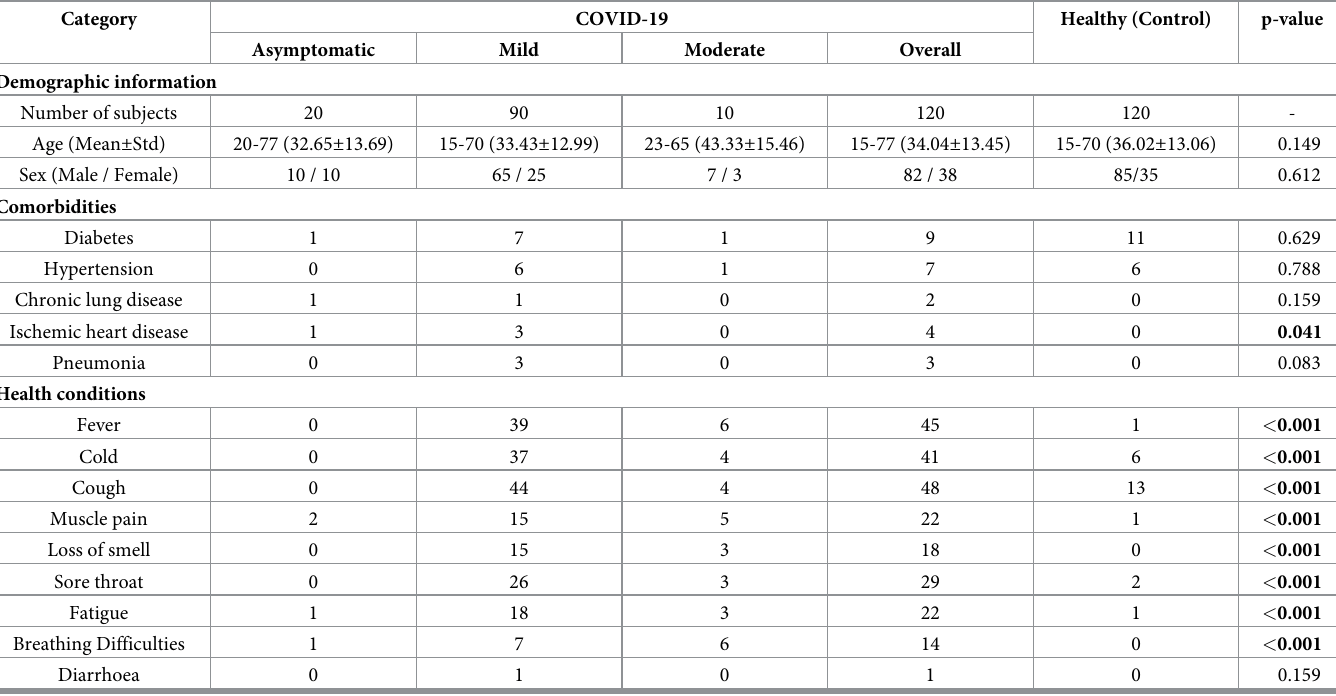
Table 1. The demographic and clinical information of COVID-19 and healthy (control) subjects included in the study. Category COVID-19 Healthy (Control) p-value Asymptomatic Mild Moderate Overall